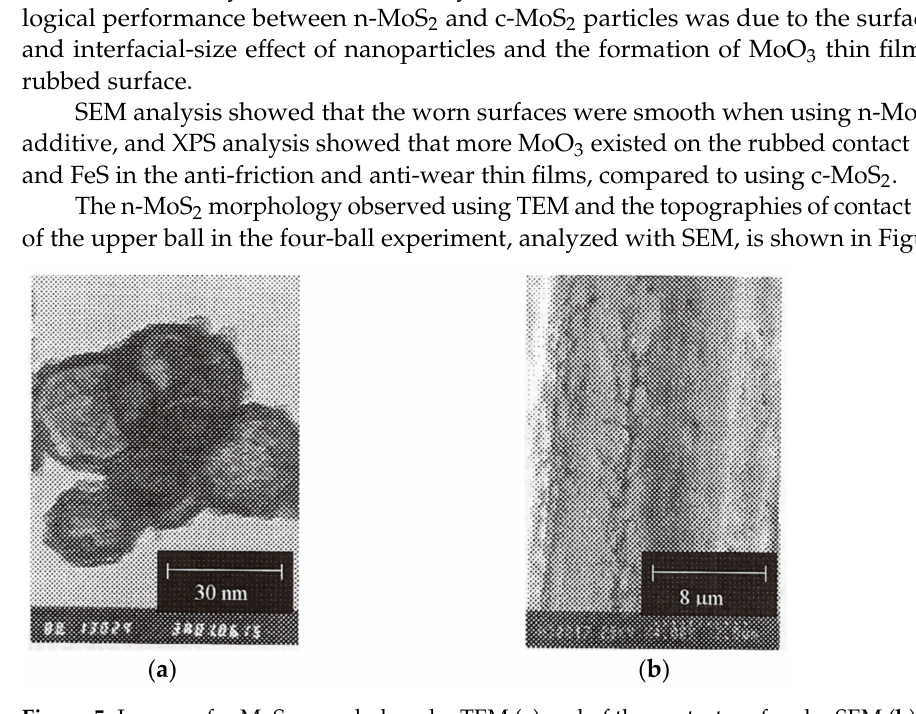
Figure 5. Images of n-MoS 2 morphology by TEM ( a ) and of the contact surface by SEM ( b